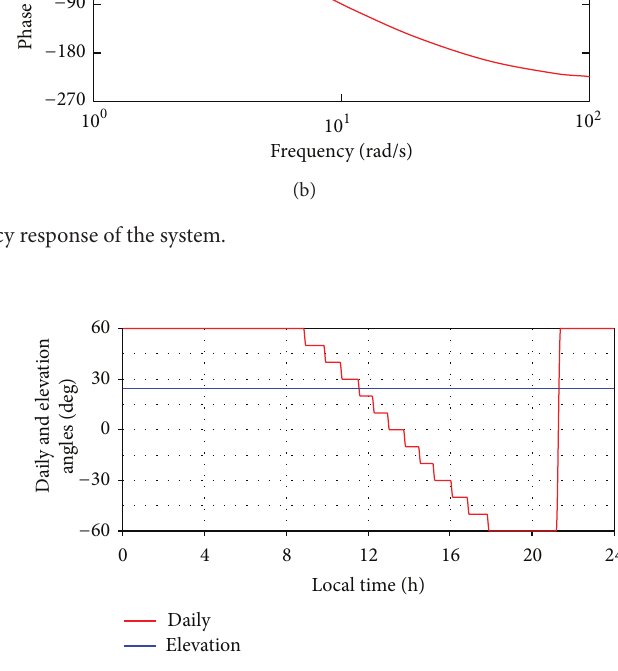
Figure 11: The motion laws of the PV module (daily and elevation